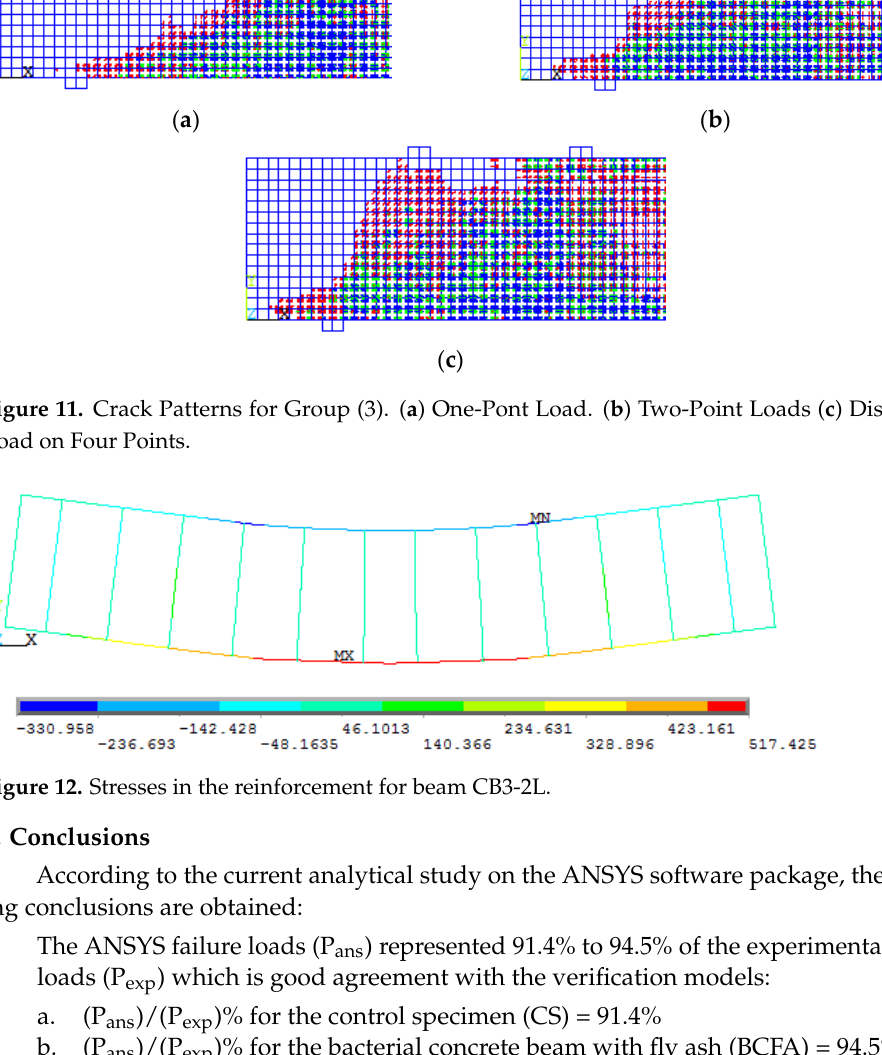
Figure 10. Load-Displacement Curves for Group (3).